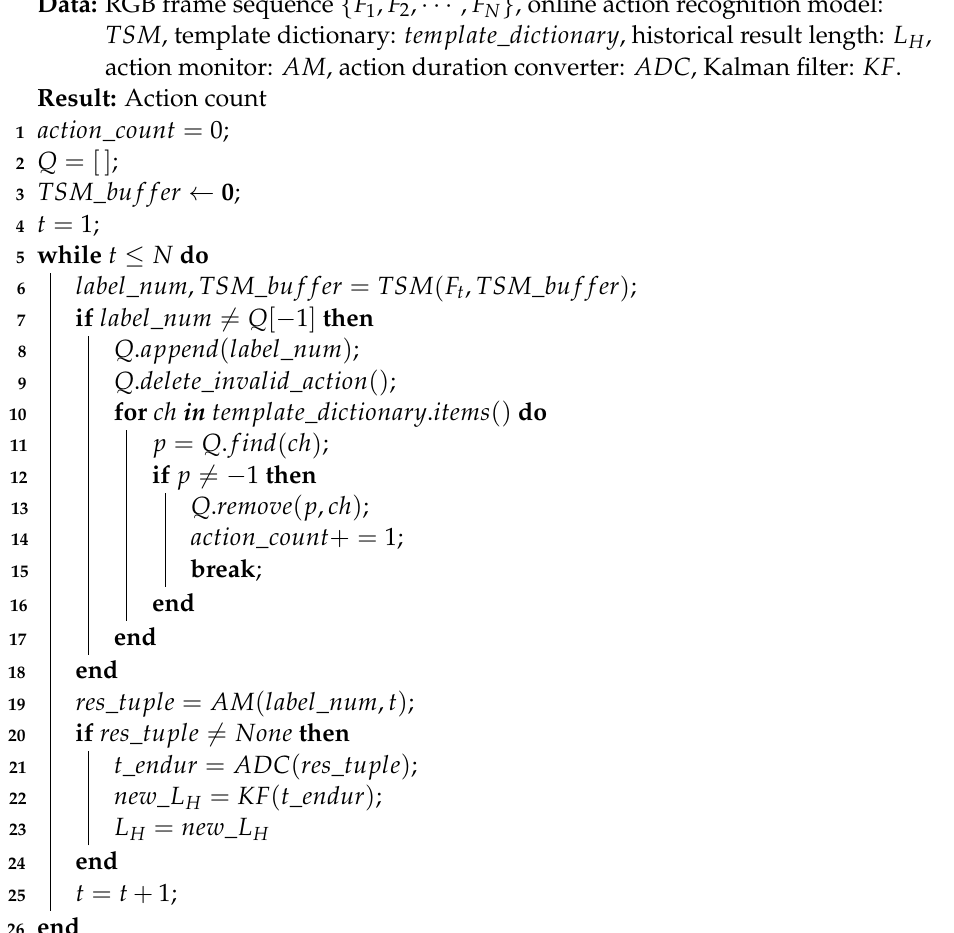
Algorithm 1: Counting the repetitive movements of